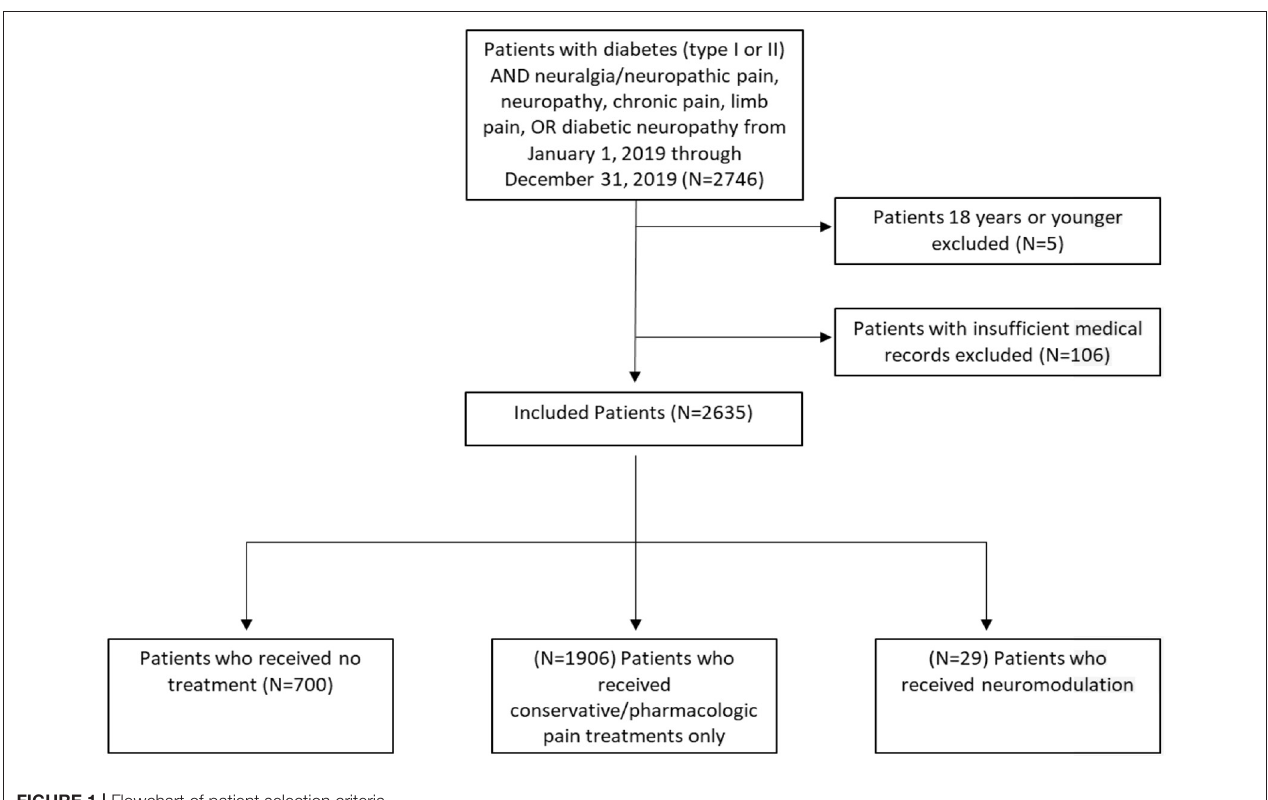
FIGURE 1 | Flowchart of patient selection criteria.